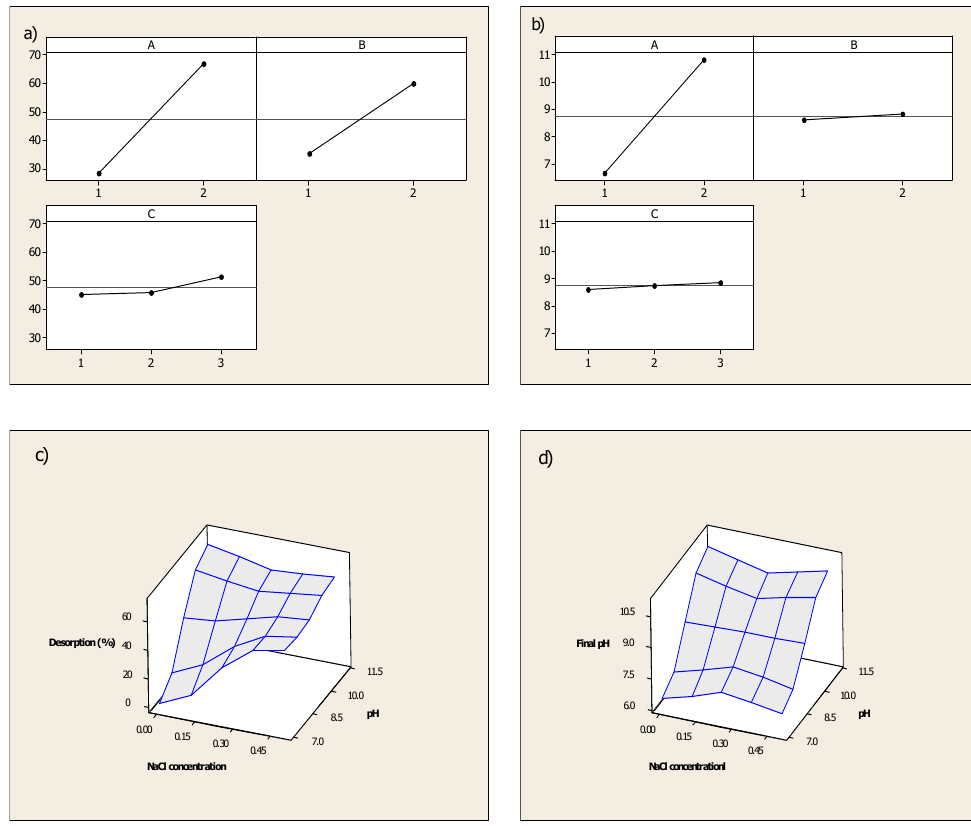
Figure 7. The main effect plots for ( a ) desorption efficiency and ( b ) final pH. Three-dimensional surface plots for ( c ) desorption efficiency and ( d ) final pH.